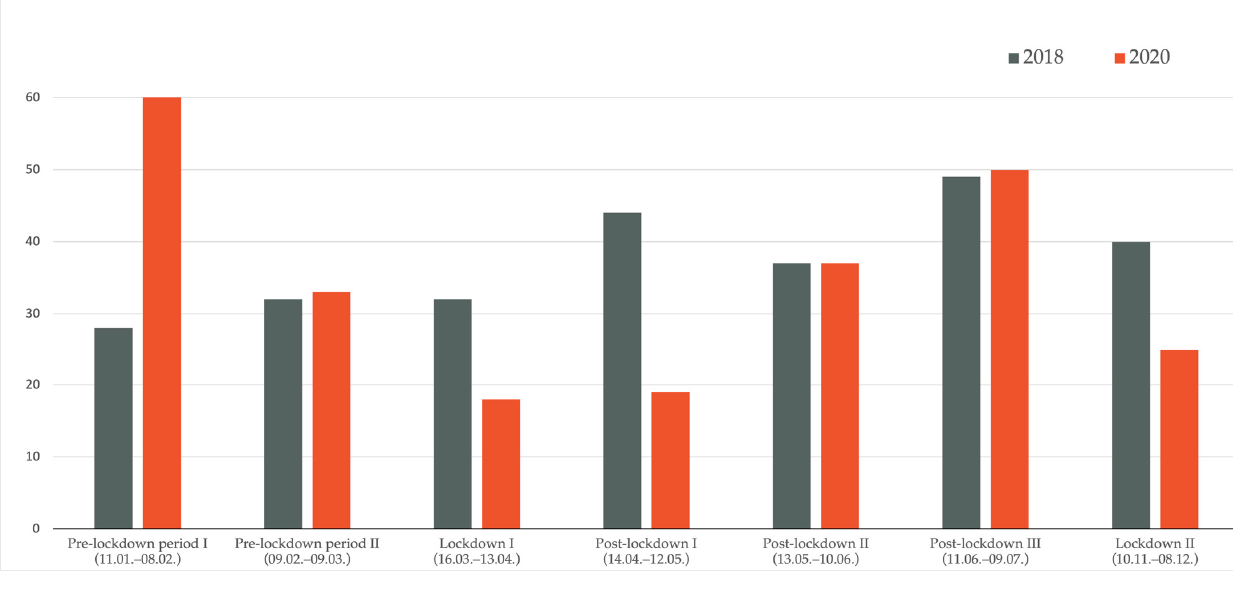
Figure 1. Comparison of melanoma cases 2018 versus 2020. A significant difference was detected for the first